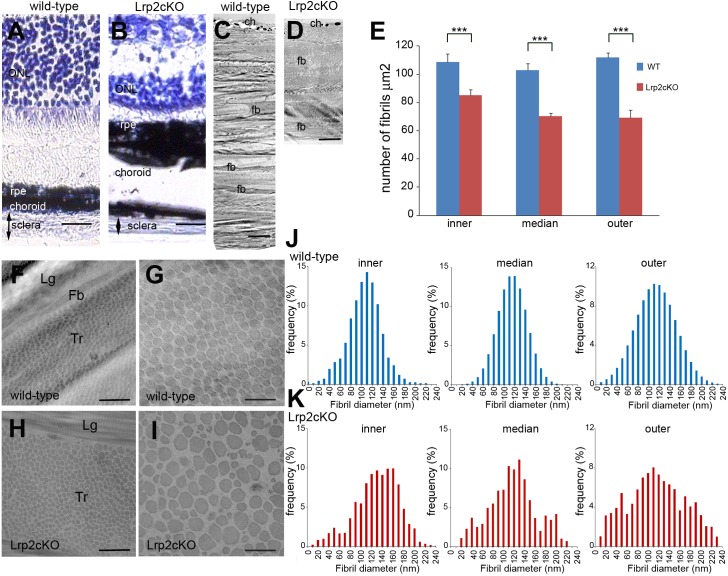
Scleral modifications in Lrp2
FoxG1.cre-KO mutant eyes.Nissl staining of retinal sections in control (A) and mutant (B) eyes shows reduced scleral thickness at P90. The choroid and occasionally the RPE appear thicker at the posterior pole of the mutant eyes. Transmission electron micrographs of the posterior sclera wall (C, D) shows that the collagen fibrils form well-organized lamellae in the control sclera (C); in the mutant fibril-poor areas and impaired packing are evident (D). Contrary to the control sclera the collagen fibril density is lower in all layers of the mutant sclera (E). Transmission electron micrographs showed fibril collagen organization within a lamella of the posterior sclera (F, H) and in localized areas (G, I) of control (F, G) and mutant (H, I). Fibrils were morphologically abnormal with irregular contours and heterogeneous diameters in the mutants. Measurements of cross-sectional diameters of fibrils from the inner, middle and outer posterior sclera in control (J) and mutant eyes (K). The mean fibril diameter distribution is modified in the mutants in all three layers; the frequency of very small as well large diameter fibrils is increased. (ch) choroid, (fb) fibroblast, (Lg) longitudinal and (Tr) transversal orientation of the cross-sectioned fibrils. Two-tailed unpaired t test was used. ***P<0.001, Values are mean ± SEM of 3 animals per genotype; see methods. Scale bars: 50 μm in A, B; 3.5 μm in C, D; 1.2 μm in F, H; 300 nm in G, I.